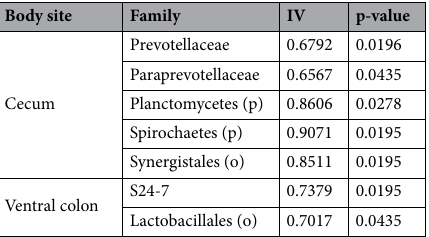
Table 1. Families identified to be most significant indicators based on single body sites, which include the indicator value (IV) and p-value for each. ( o order, p phylum).